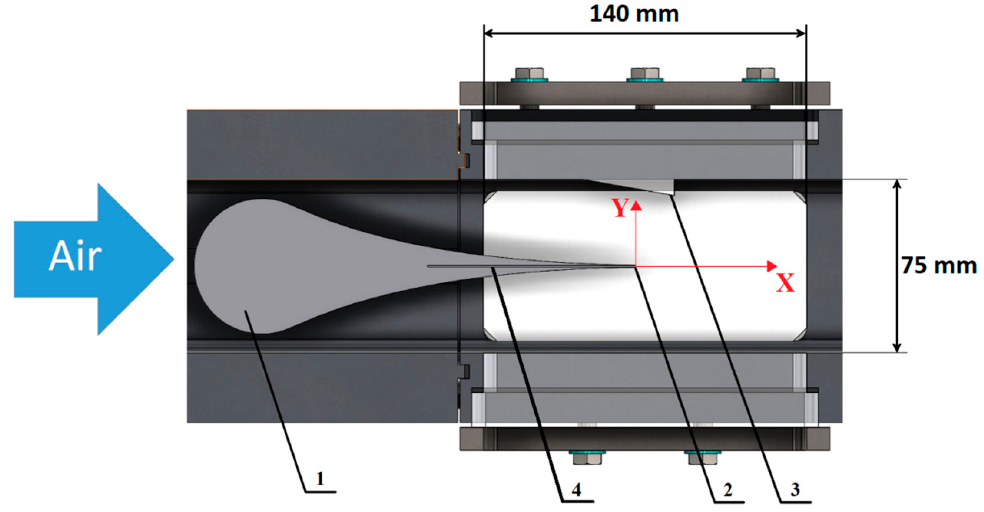
Figure 2. The layout of the wedge in the experimental setup: 1—central aerodynamic nozzle; 2—nozzle for water supply; 3—wedge; 4—water supply channel. 2—nozzle for water supply; 3—wedge; 4—water supply